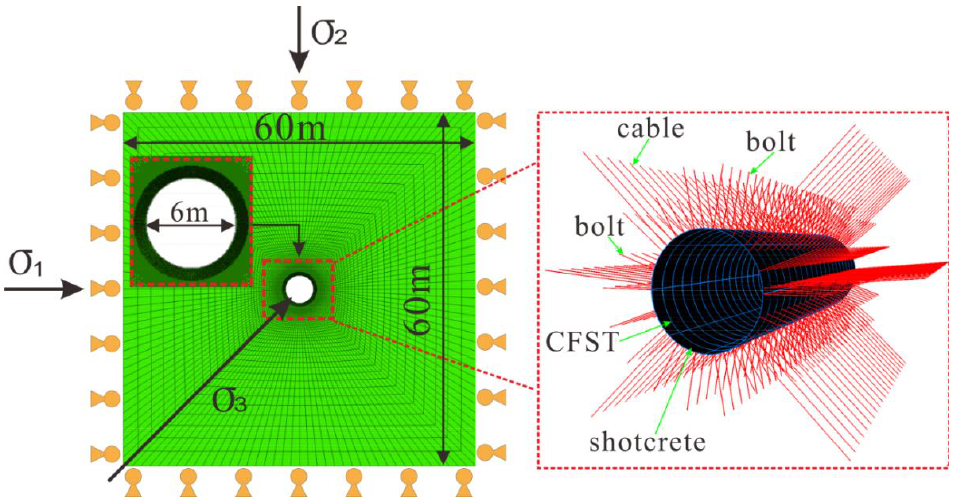
Figure 17. Numerical model of the initial support.